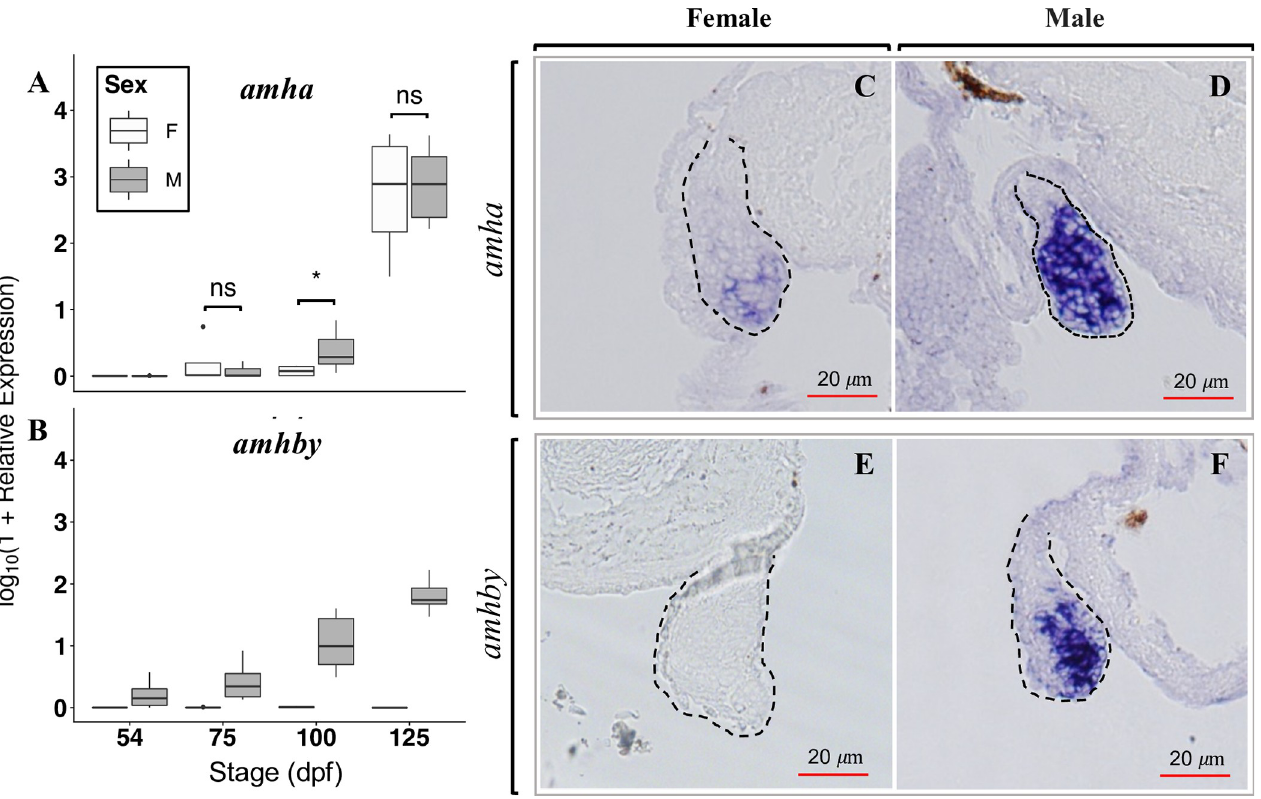
Fig 3. Temporal and spatial expression of amha and amhby mRNA in male and female developing gonads. A-B : Boxplots showing the first quantile, median, and the third quantile of the temporal expression of (A) amha and (B) amhby during early development of E . lucius measured by qPCR. Outliers are displayed as dots. The mRNA expression of amha and amhby was measured at 54, 75, 100, and 125 days post fertilization (dpf) in male and female samples of E . lucius and the log 10 of their relative expression is presented on the graph. Significant P-values ( < 0.05) for Wilcoxon signed rank test between male and female expression at each time point are indicated by � and ‘ns’ indicates non-significant P-values. Statistical tests were not performed on amhby expression between sexes because of the complete absence of amhby expression in females. C-F : In situ hybridization on histological sections revealed the localization of amha in both 80 dpf (C) female and (D) male gonads, with a stronger expression in male gonads. A high amhby mRNA expression is detected in the male gonad (F), with no signal detected in female gonad (E). The red scale bars denote 20 μ m and the dashed lines outlines the gonadal